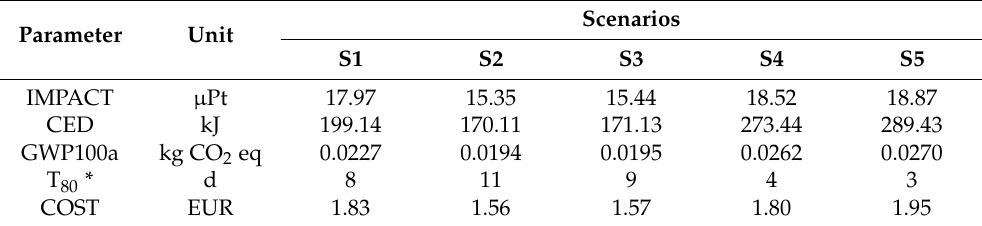
Table 1. Summary of the results obtained for the analyzed criteria. Parameter